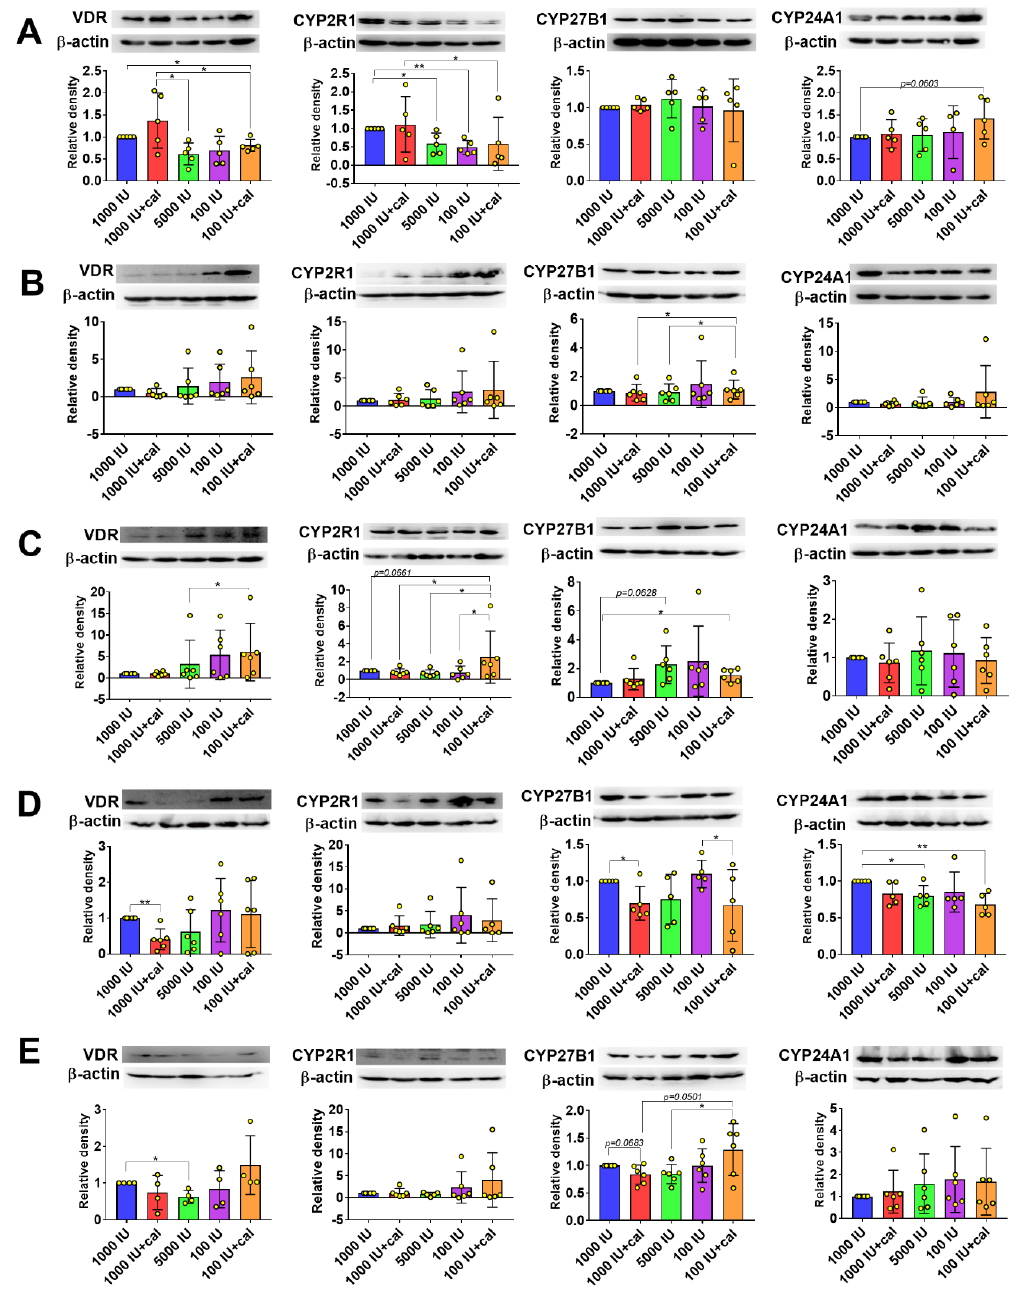
Figure 7. Expression of vitamin D receptor (VDR), CYP2R1, CYP27B1, and CYP24A1 in the tissues of mammary gland tumor-bearing mice. Expression of proteins in the tumor tissue of mice bearing ( A ) 4T1, ( B ) 67NR, and ( C ) E0771 tumors. Expression of proteins in the ( D ) kidney and ( E ) liver of mice